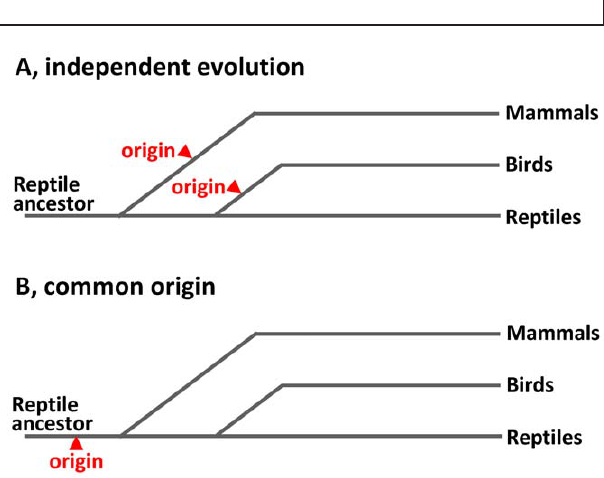
Figure 1. Background and hypothesis. (A) Anatomical works concluded that the specialized cardiac conduction system evolved independently in mammals and birds because similar structures could not be found in ectothermic vertebrates. (B) We are testing the hypothesis that a primordial version of the specialized cardiac conduction system can be found in ectothermic